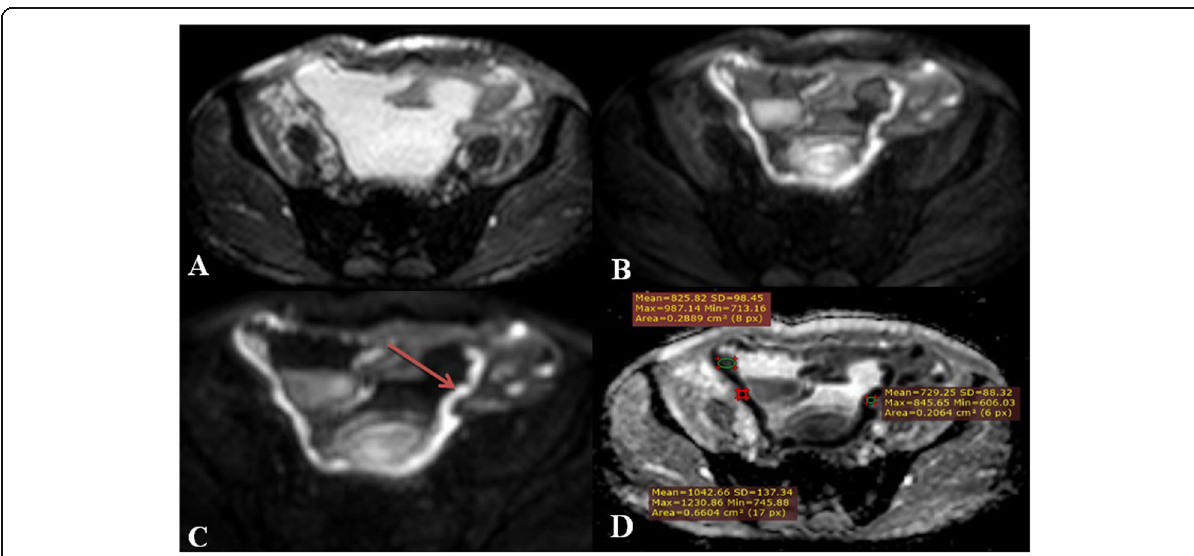
Fig. 3 Fifty-four year old female patient with history of surgically excised ovarian cystadenocarcinoma presented by abdominal pain and distention. a DWI at b 0. b DWI at b 500. c DWI at b 1000. d ADC map. The images showed sheets of peritoneal thickening (arrow) with high signal in DWI and low in ADC map, impressive of restricted diffusion with average ADC value 0.83 ± 0.08 × 10 − 3 mm 2 /s. Final diagnosis after pathological examination was peritoneal metastatic